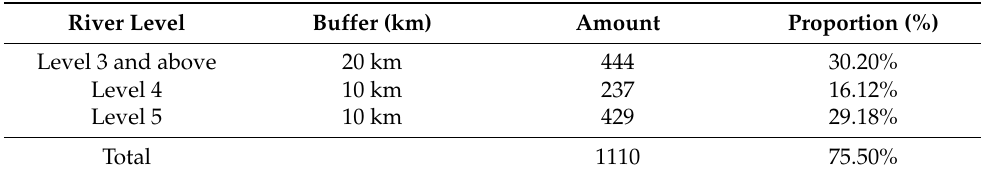
Figure 7. Distribution map of beautiful leisure villages and geographical environment overlap in China. Table 5. Analysis of the river buffer zones of all BLVC.